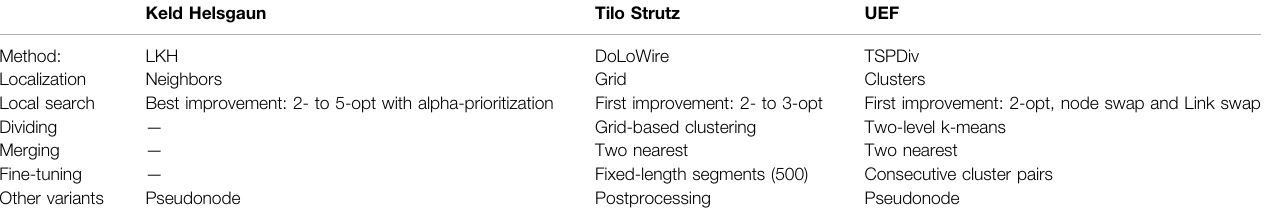
TABLE 1 | Summary of the submitted methods.